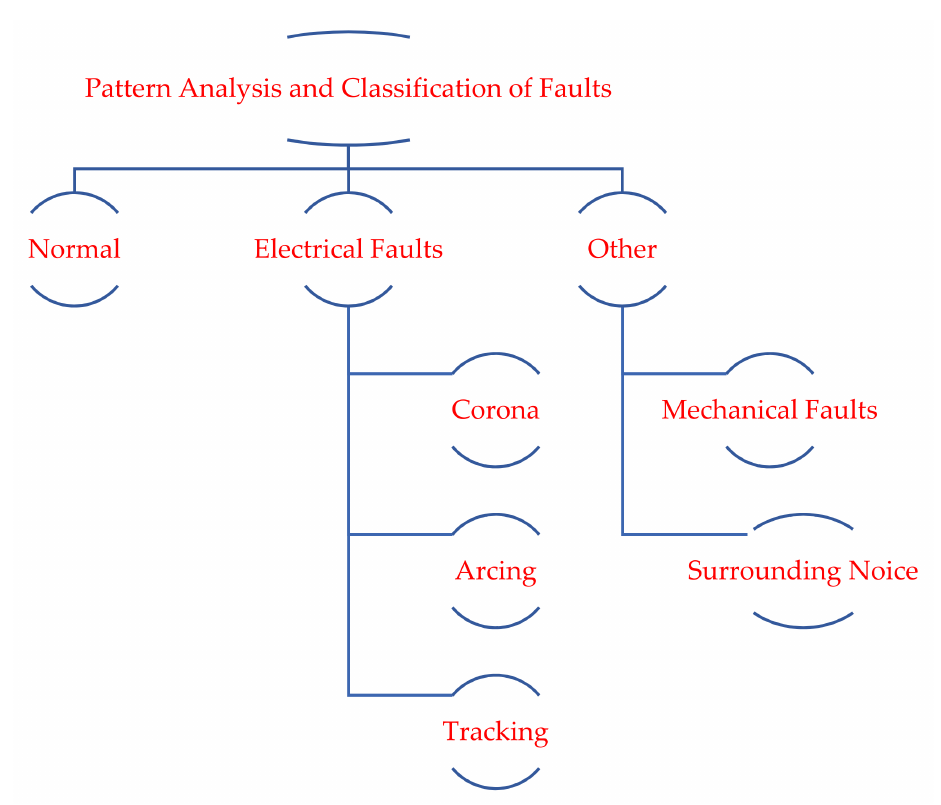
Figure 1. The mechanical and electrical faults of the